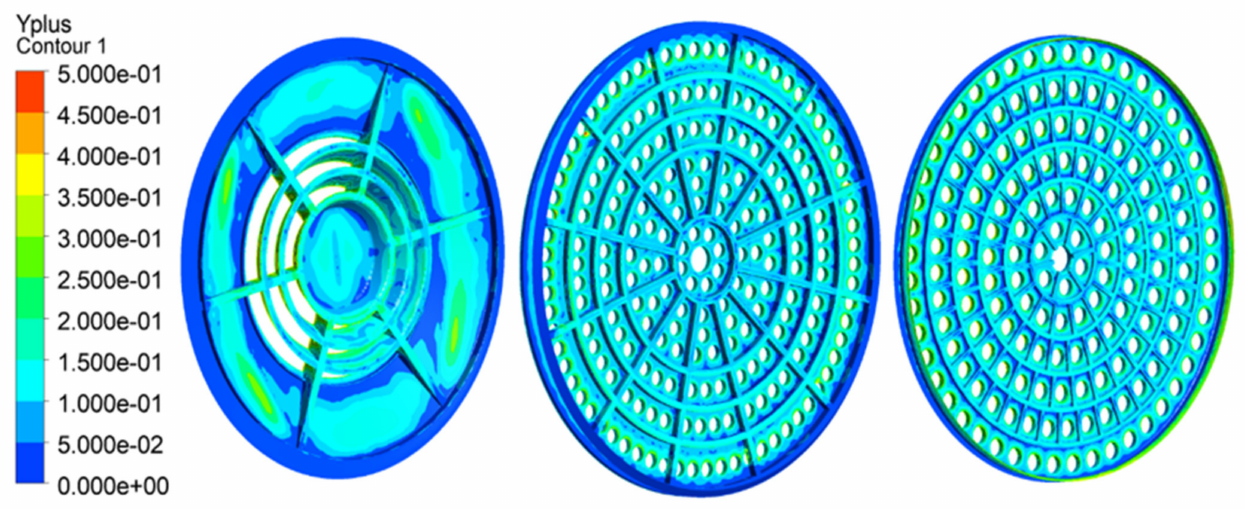
Figure 3. Distribution of y+ values on canister lid and two perforated